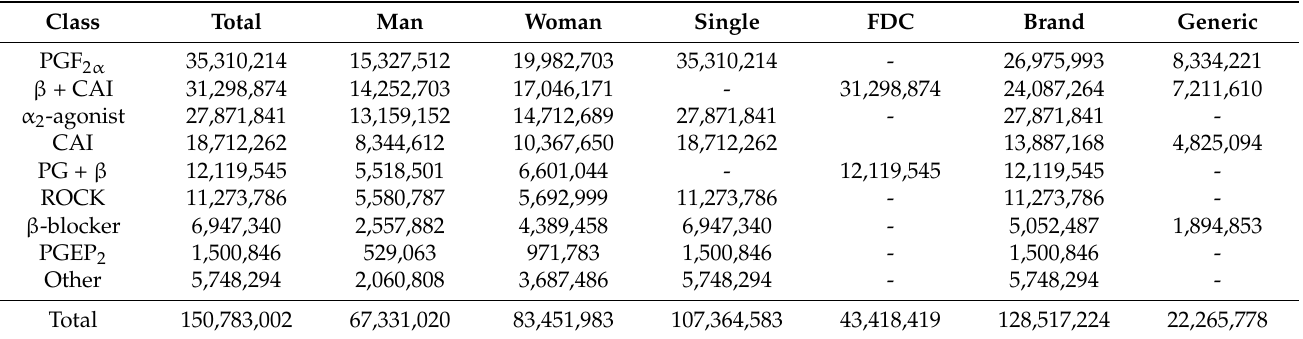
Table 2. Total prescription dose and prescription dose of each medication class.